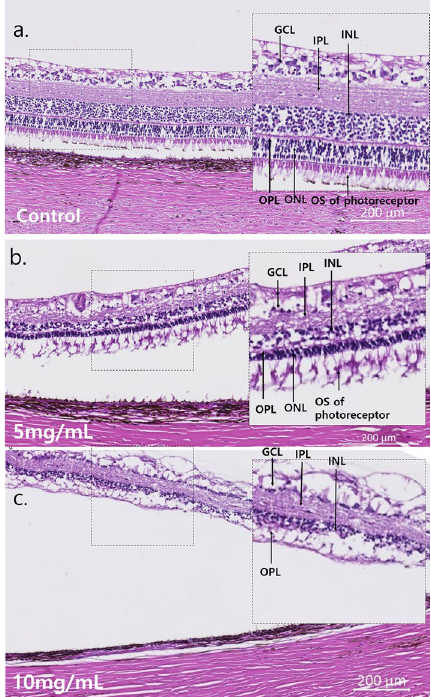
Figure 8. H&E staining of a representative case of the 5 mg/mL MNU and 10 mg/mL MNU groups. ( a–c ) Each magnified H&E staining image was from the right side and is shown with a dashed-line box. ( a ) H&E staining of a control case. Each count number of ONL, INL, and GCL in dotted enlarged area was 201, 307, and 49, respectively. ( b ) H&E staining of a representative case with moderate outer degeneration in the 5 mg/mL group. In H&E staining, all the INL, GCL and NFL were intact, but the density of INL and GCL decreased. Each count number of ONL, INL, and GCL in dotted enlarged area was 100, 91, and 16, respectively. ( c ) H&E staining of a representative case with severe outer degeneration in the 10 mg/mL group. ONL cells were rarely observed among INL or combined INL with ONL cells. Each count number of ONL, INL, and GCL in dotted enlarged area was 0, 112, and 29, respectively. H&E hematoxylin and eosin, GCL ganglion cell layer, IPL inner plexiform layer, INL inner nuclear layer, OPL outer plexiform layer, ONL outer nuclear layer, OS outer segment, RPE retinal pigment